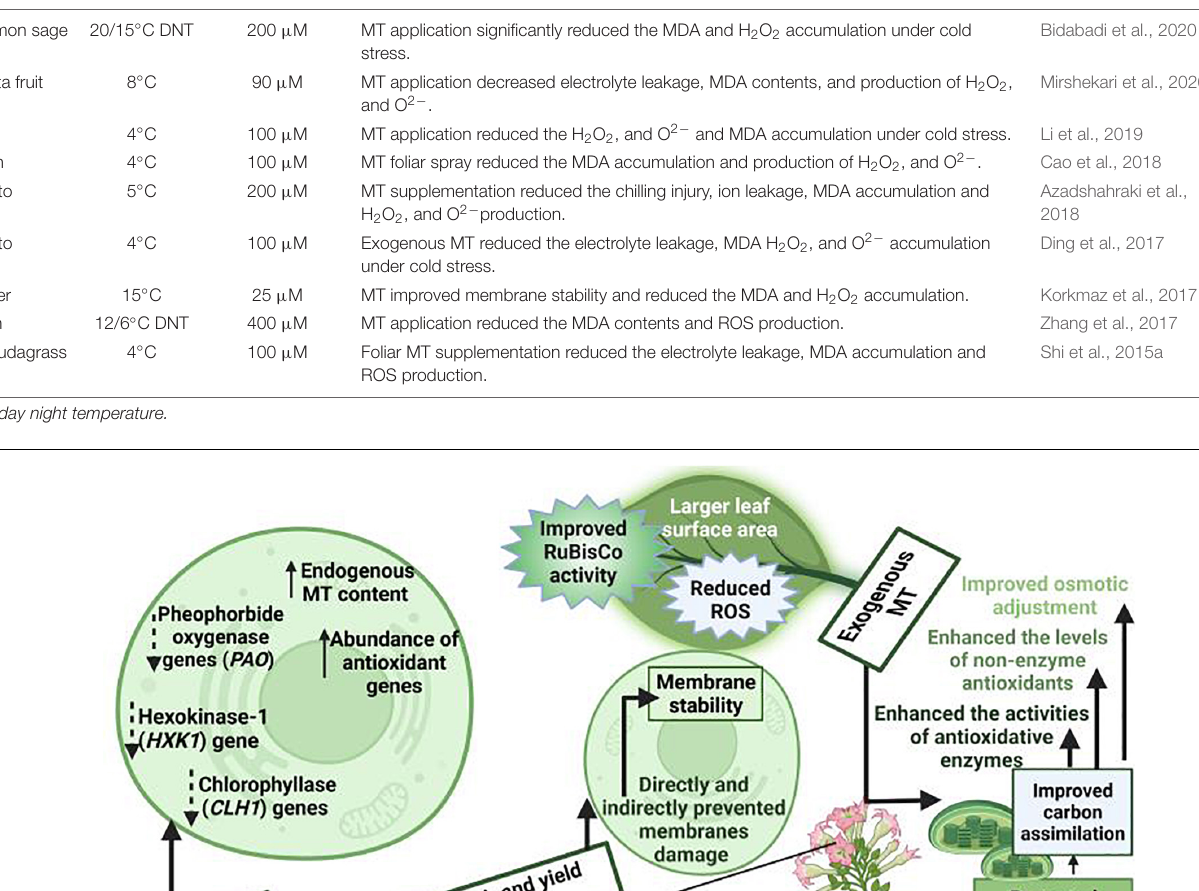
TABLE 3 | Effect of melatonin supplementation on different oxidative stress markers under cold stress. Crop Cold stress MT application Effects